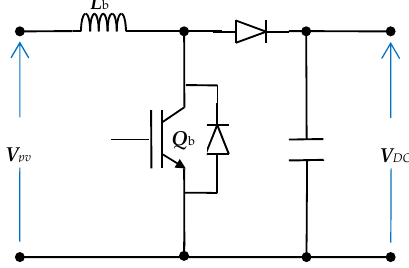
Figure 3. The power circuit of the boost converter.